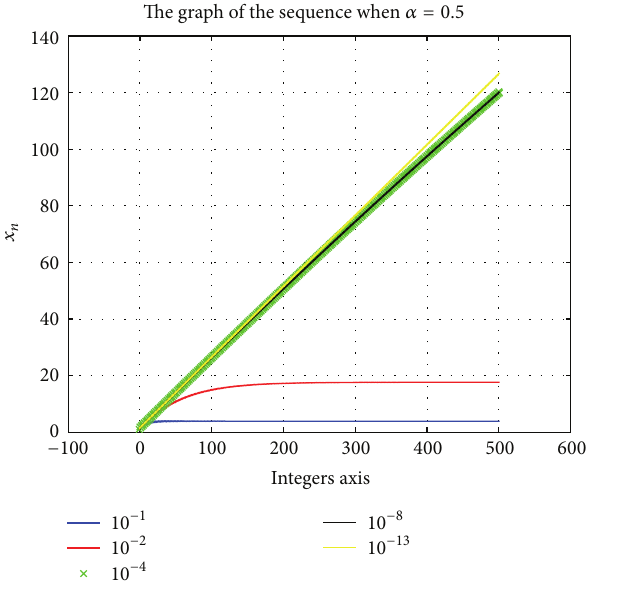
Figure 2: When 𝑚 = 1 and 𝑘 → 0 the positive solution is